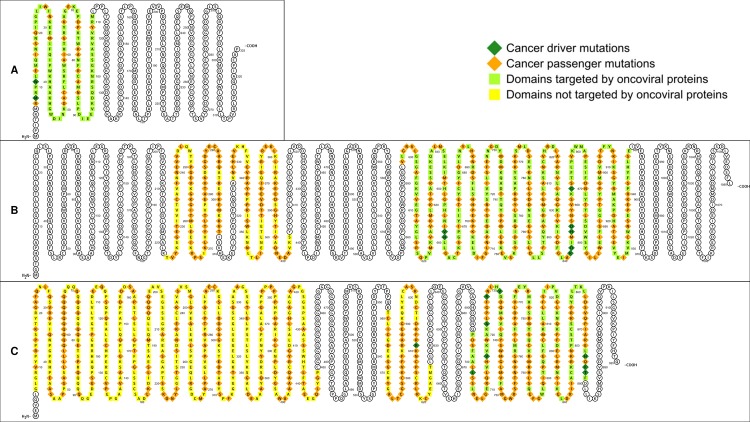
Oncoproteins having at least one oncovirus-targeted domain (OVTD), where driver mutations are either exclusively found or enriched.(A) driver:passenger ratio in oncovirus-targeted PF00605 domain of IRF1 is higher than the mean driver:passenger ratio for all oncoproteins; (B) driver mutations are exclusively found in oncovirus-targeted PF07714 domain of PDGFRA; (C) driver mutations are enriched in oncovirus-targeted PF00104 domain of AR.